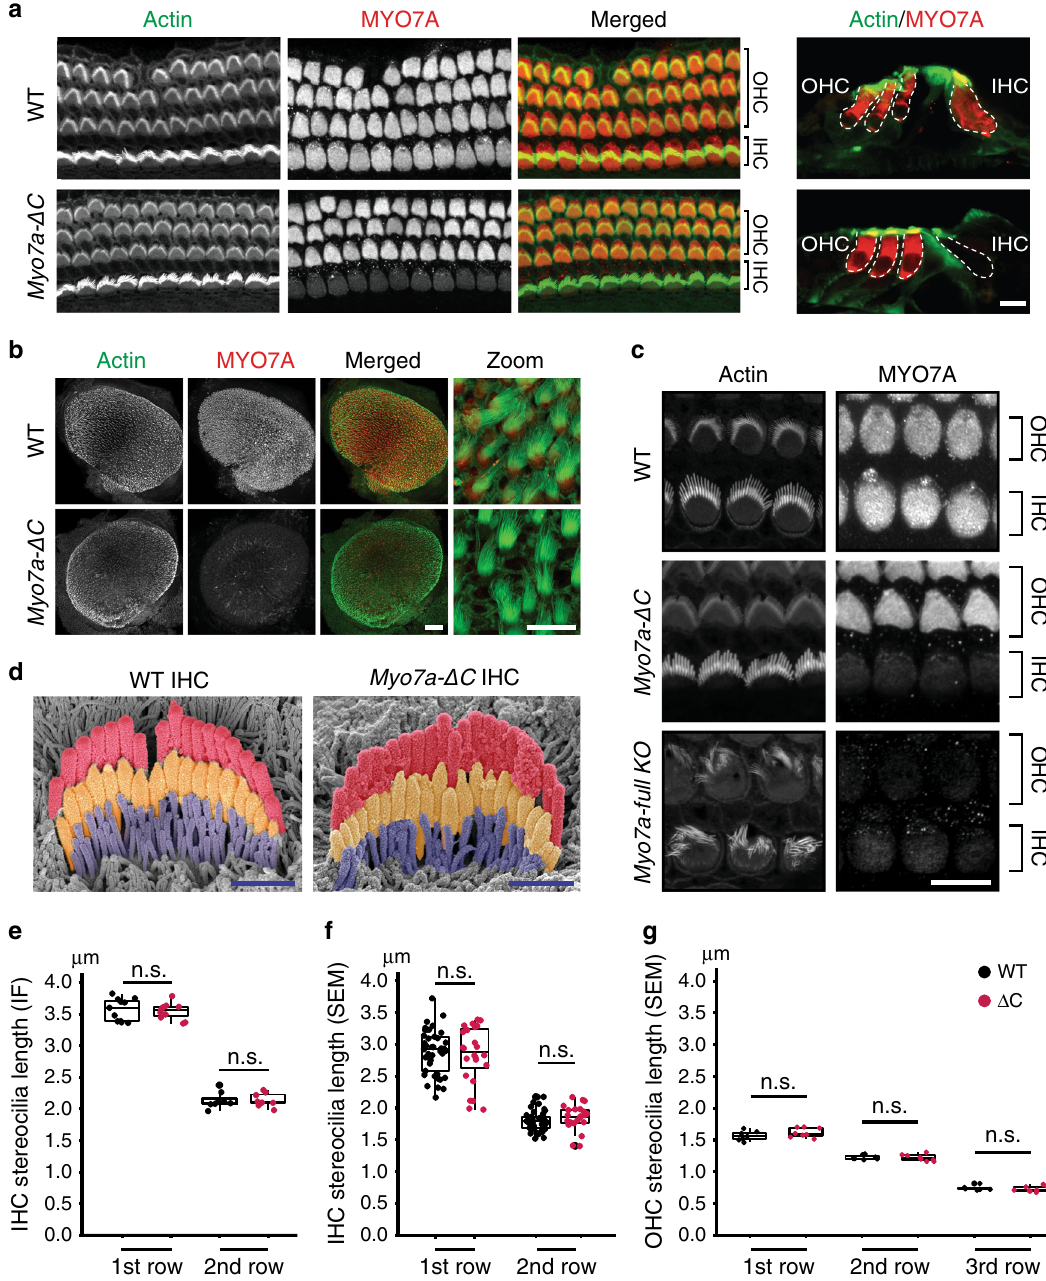
Fig. 2 Myo7a-C deletion primarily affects MYO7A expression in IHCs and utricle hair cells. a MYO7A immunoreactivity in WT and Myo7a- Δ C organ